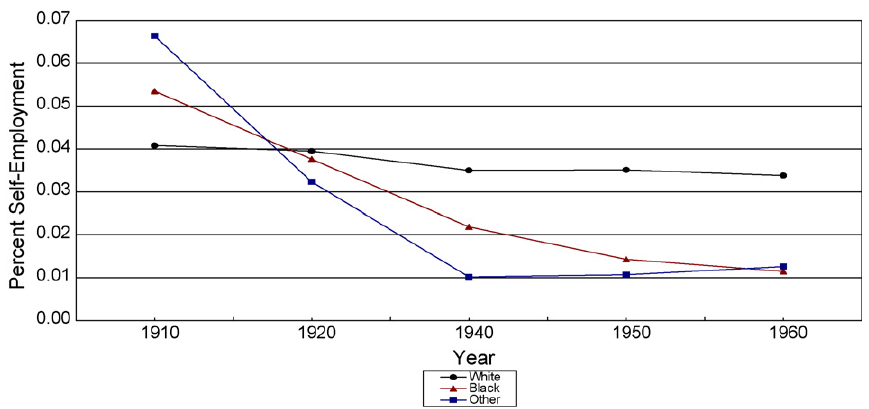
Fig. 2. U.S. non-immigrant, self-employment rates—Midwest region: 1910–1960.